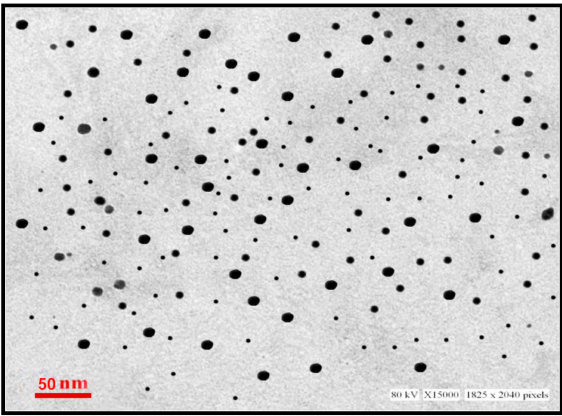
Figure 3. TEM micrograph of DFX-AuNPs.